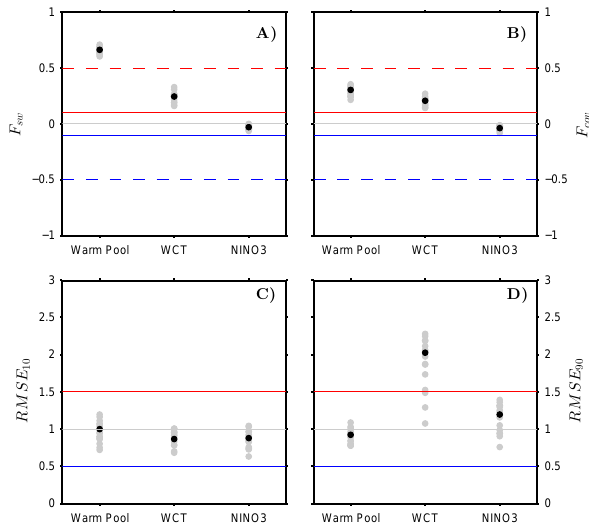
Fig. 6. Values of the (A) F sw , (B) F cov , (C) RMSE 10 and (D) RMSE 90 metrics calculated over the Warm Pool, Western Cold Tongue (WCT) and NINO3 boxes using both the entire 750 yr of model simulation data (black dots) and also this same data split into fifteen non-overlapping 50 yr intervals (grey dots). The locations of these regions are shown on Figs. 2/4. The solid and dashed reference lines represent the contoured levels shown on Fig. 2 (for F sw and F cov ) and Fig. 4 (for RMSE 10 and RMSE 90 ).